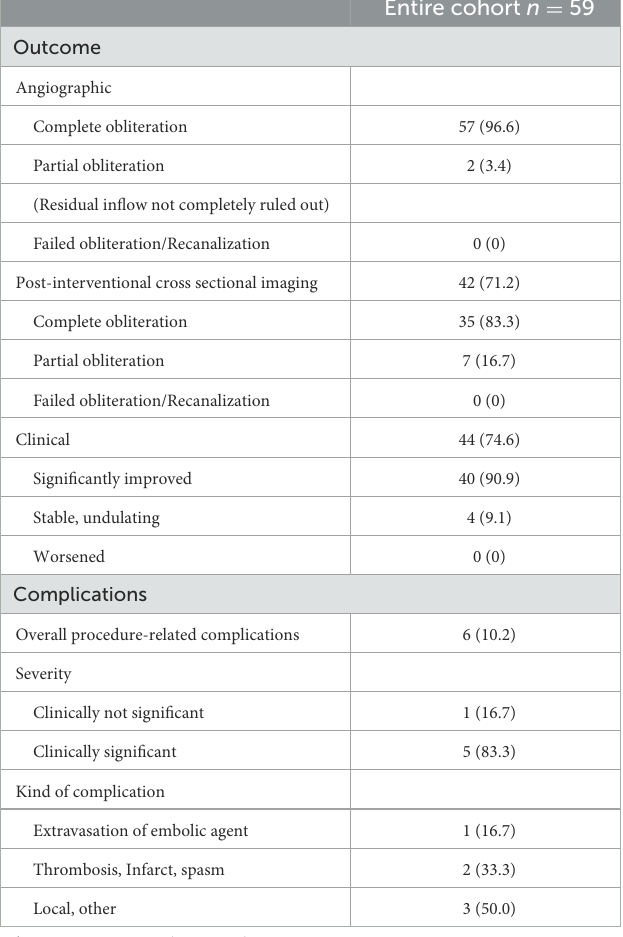
TABLE 4 Outcome and